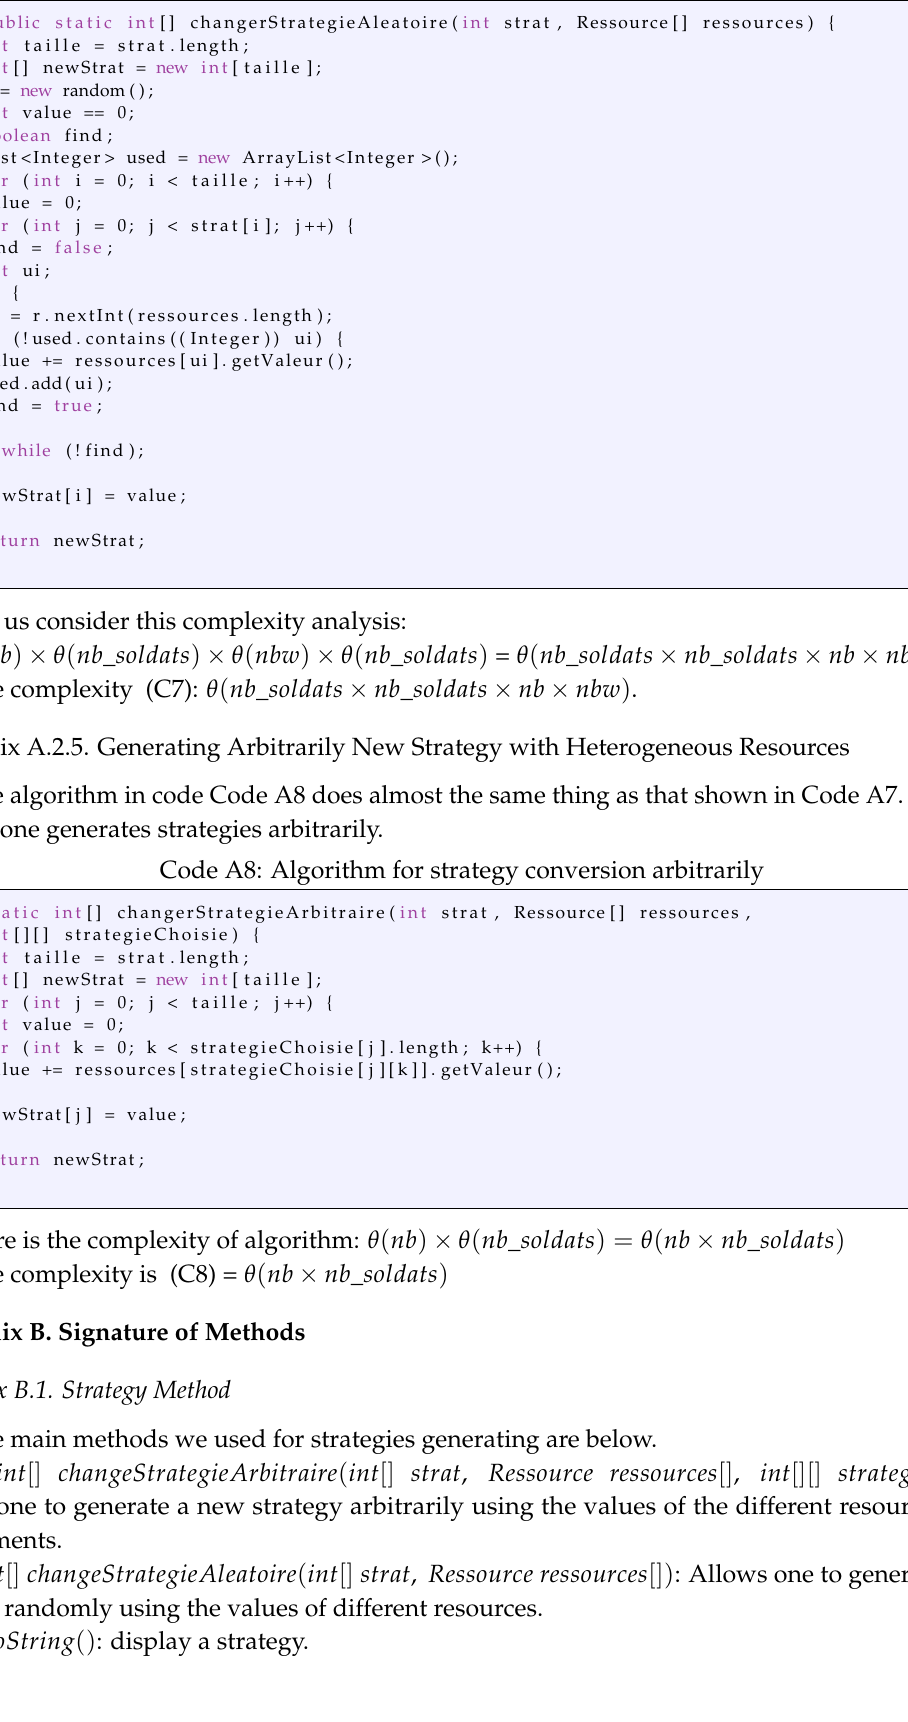
Code A7: Algorithm for strategy conversion randomly